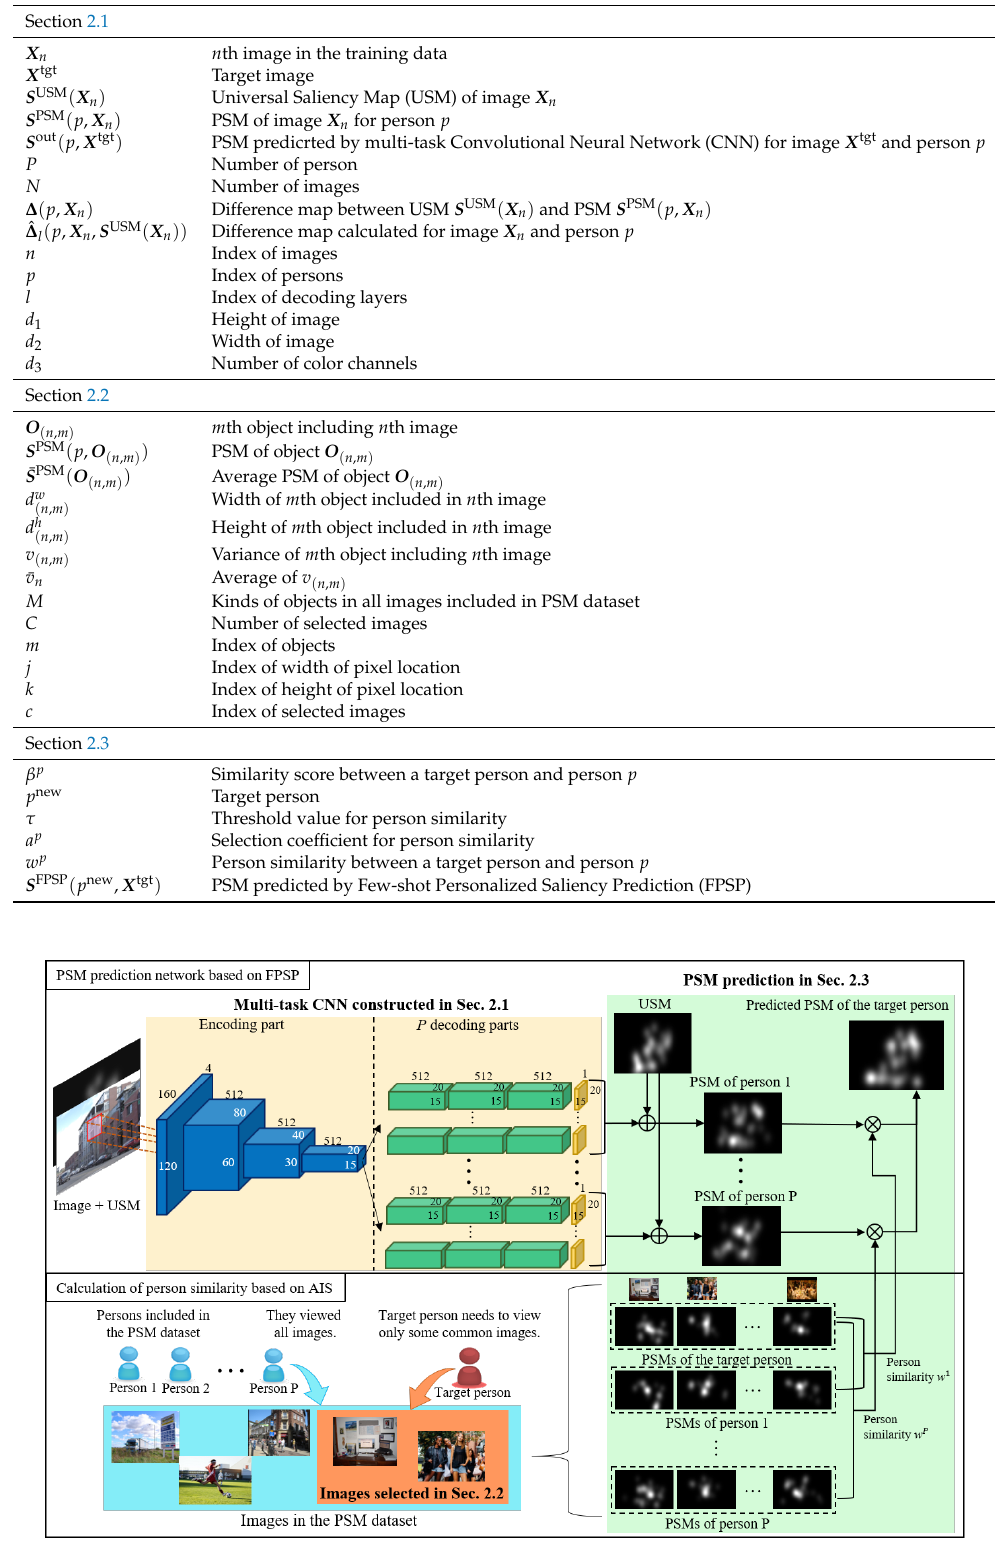
Figure 2. Overview of FPSP and Adaptive Image Selection (AIS). The upper row shows the pipeline of FPSP and the lower row shows the method for the calculation of person similarities based on